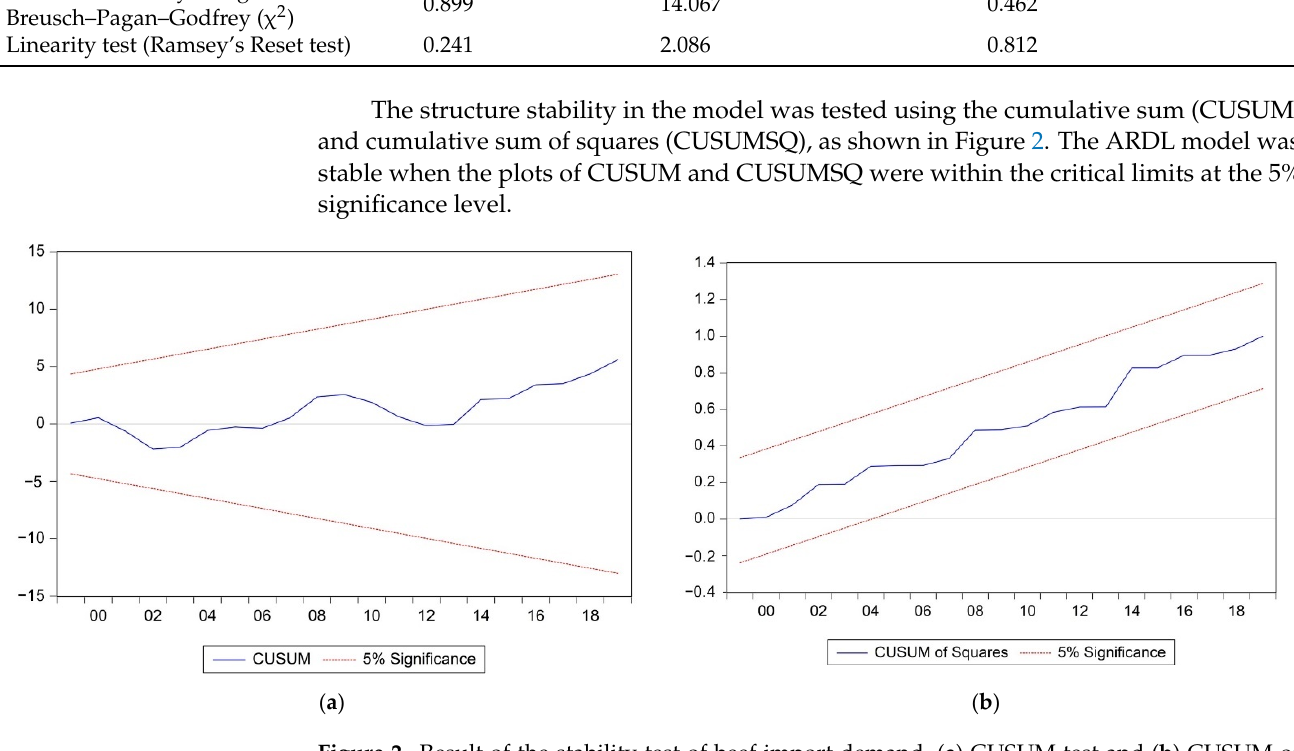
Figure 2. Result of the stability test of beef import demand, ( a ) CUSUM test and ( b ) CUSUM of square test.